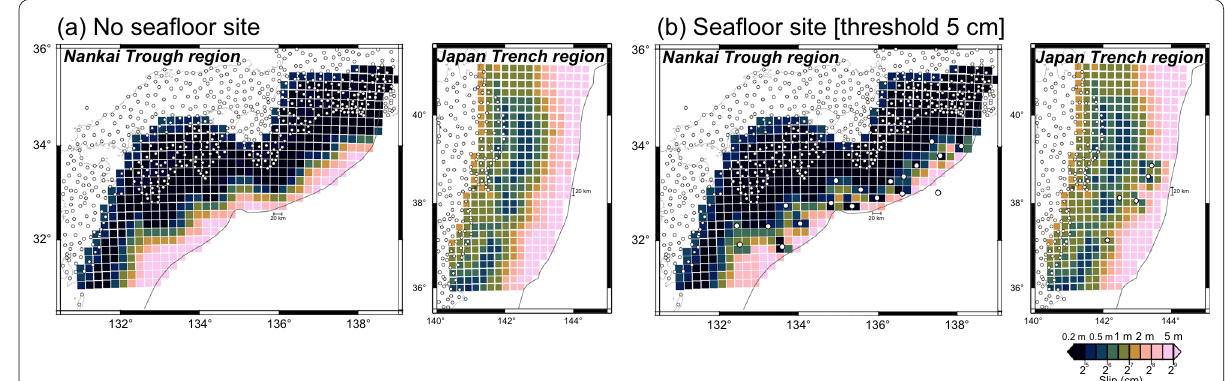
Fig. 6 Detection limit map along the Nankai Trough and the Japan Trench; a a case using no seafloor site and b a case using seafloor sites. White circles indicate seafloor and terrestrial geodetic observation sites used in each